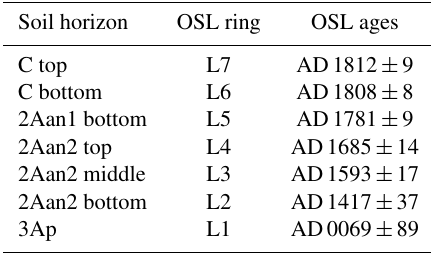
Table 1. OSL datings of the Rakt profile (Fig. 10, left).